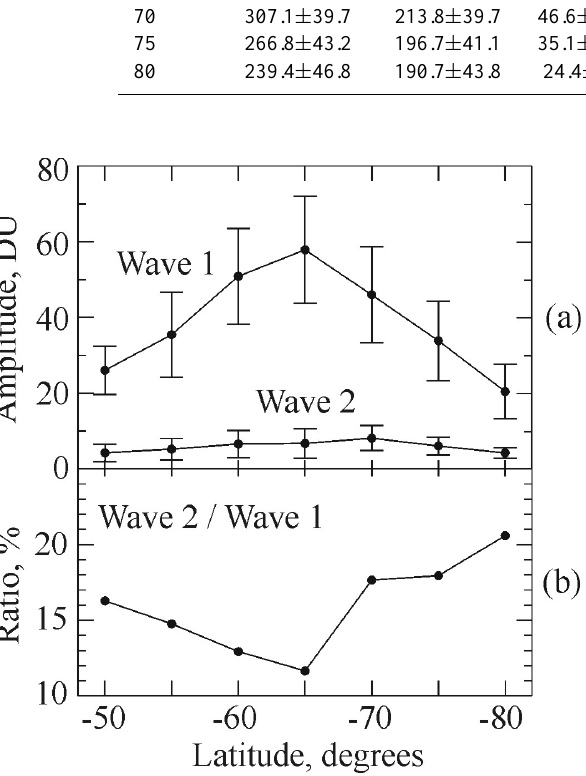
Fig. 4. As in Fig. 3, but for (a) the amplitudes of zonal wave 1 and 2 and (b) the amplitude ratio between wave 2 and wave 1. The wave amplitudes were obtained using Fourier decomposition. Fig. 5. Variation (circles) and trend (lines) of longitudinal positions of the zonal wave (a) ridge and (b) trough for the springs of 1979– 2005 at the seven latitudes between 50 ◦ S and 80 ◦ S. Colours are labelled on the right side of plot